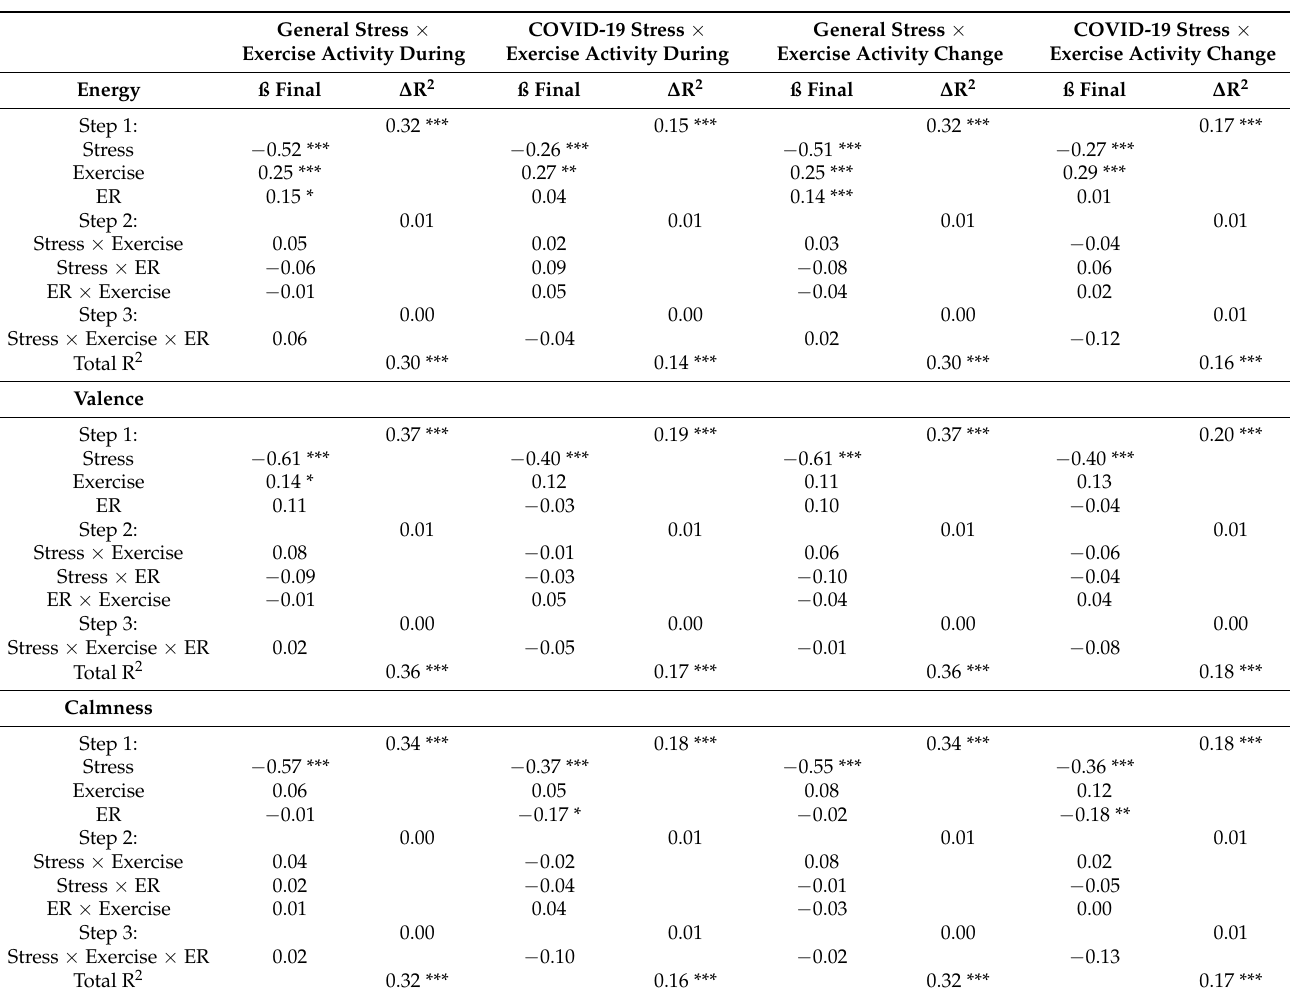
Table 4. Hierarchical regression results for mood among